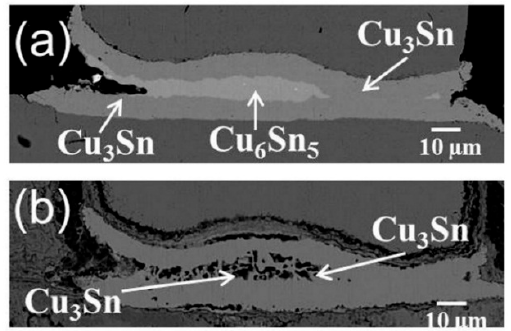
Figure 9. Cross-sectional SEM images of solder bumps with Cu column UBM aging at 185 °C for ( a ) 1000 h and ( b ) 2000 h.